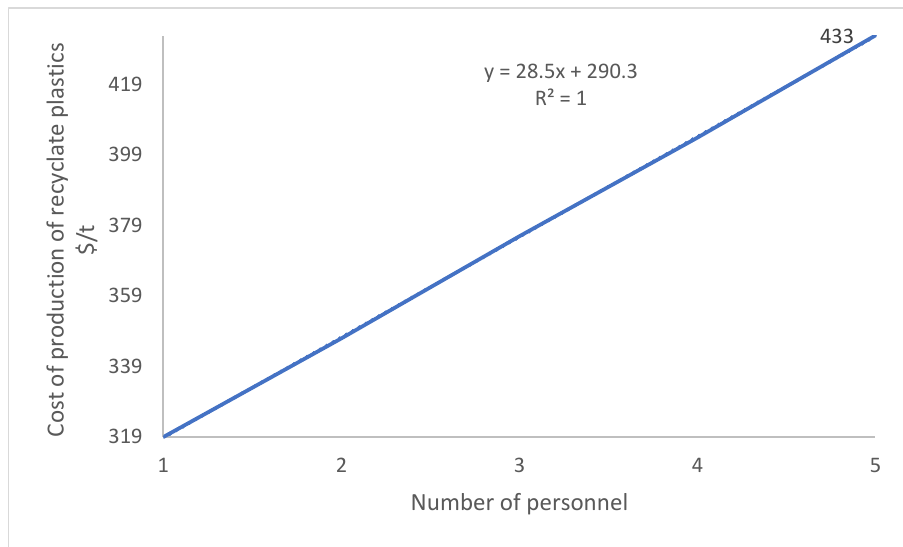
Figure 7. The effect of labor cost on the cost of production of recyclate plastics.